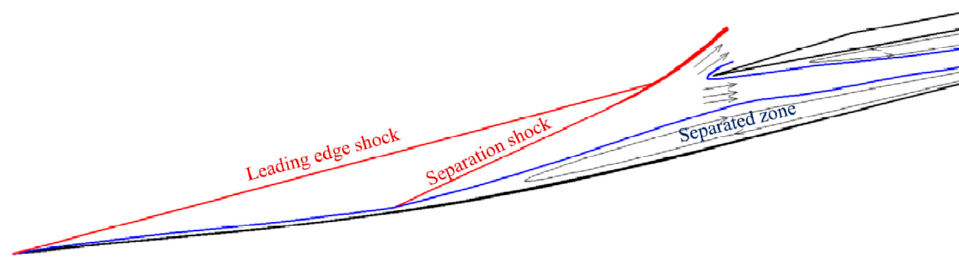
Figure 1. Flow pattern of the hypersonic inlet for the unstart condition.